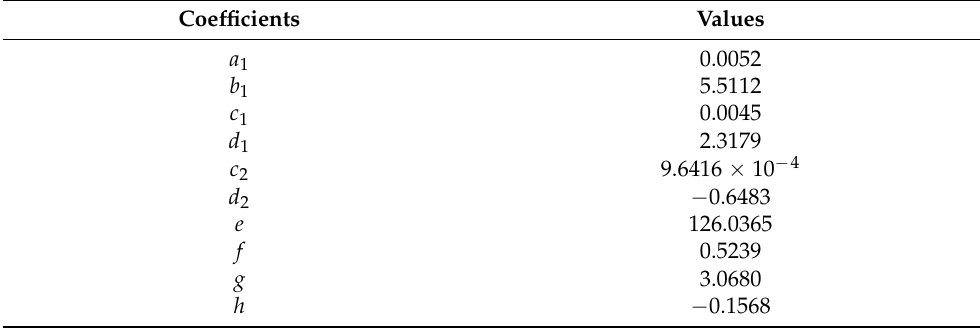
Table 1. Coefficients of the ETm model using 48 radiosonde data from 2014–2020 over Europe.